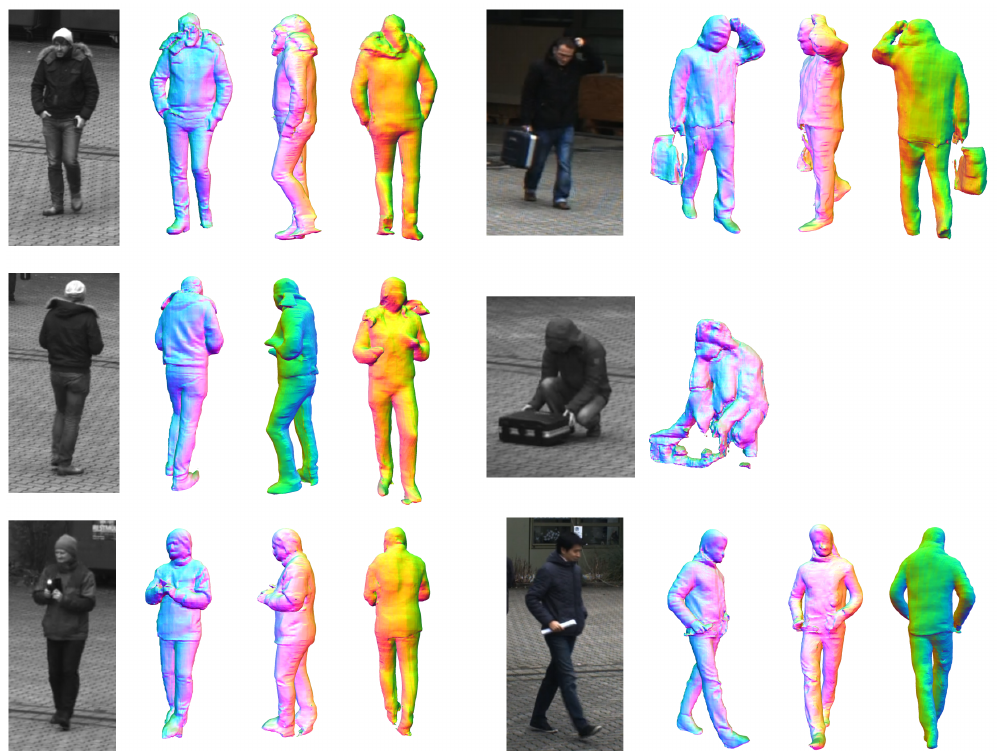
Figure 7. 3D models of different persons reconstructed from single images using PiFuHD. The reconstruction time was approximately 10 seconds per person. The size of the image patches varied between 260 × 330 and 440 × 960 pixels. Most models were successfully reconstructed from all sides. Only the kneeing man opening a suitcase (lowest resolution) could not be reconstructed from the back.